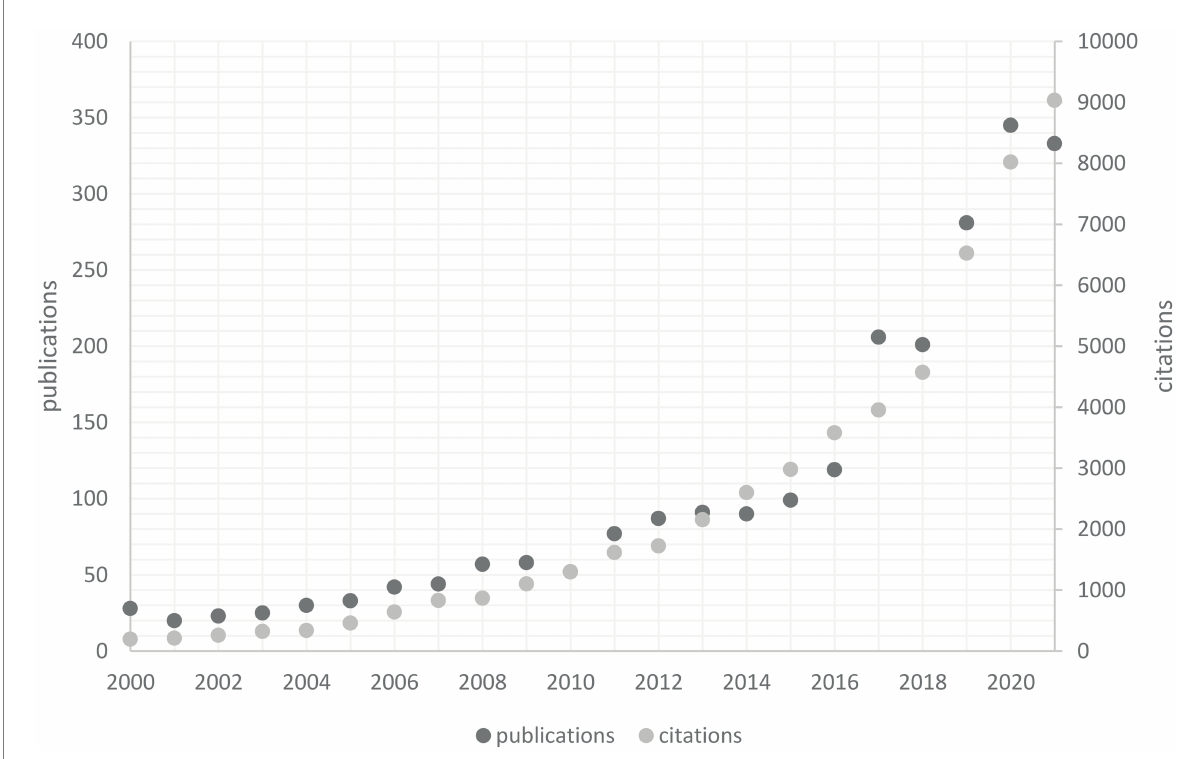
FIGURE 1 Publications and citations on Curiosity in psychology and management research from 2000 to 2021. This figure was created based on a Web of Science search for “curiosity”